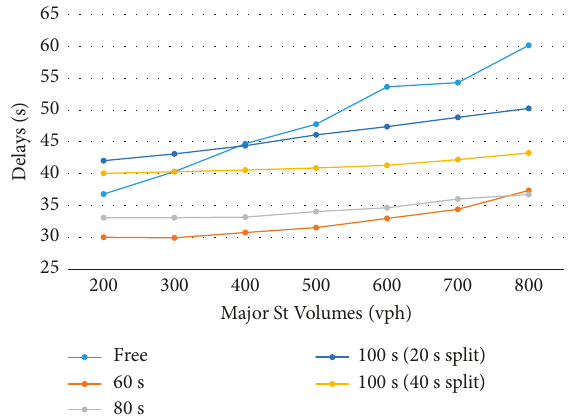
Figure 4: Average delay under minor street volume of 150vph.